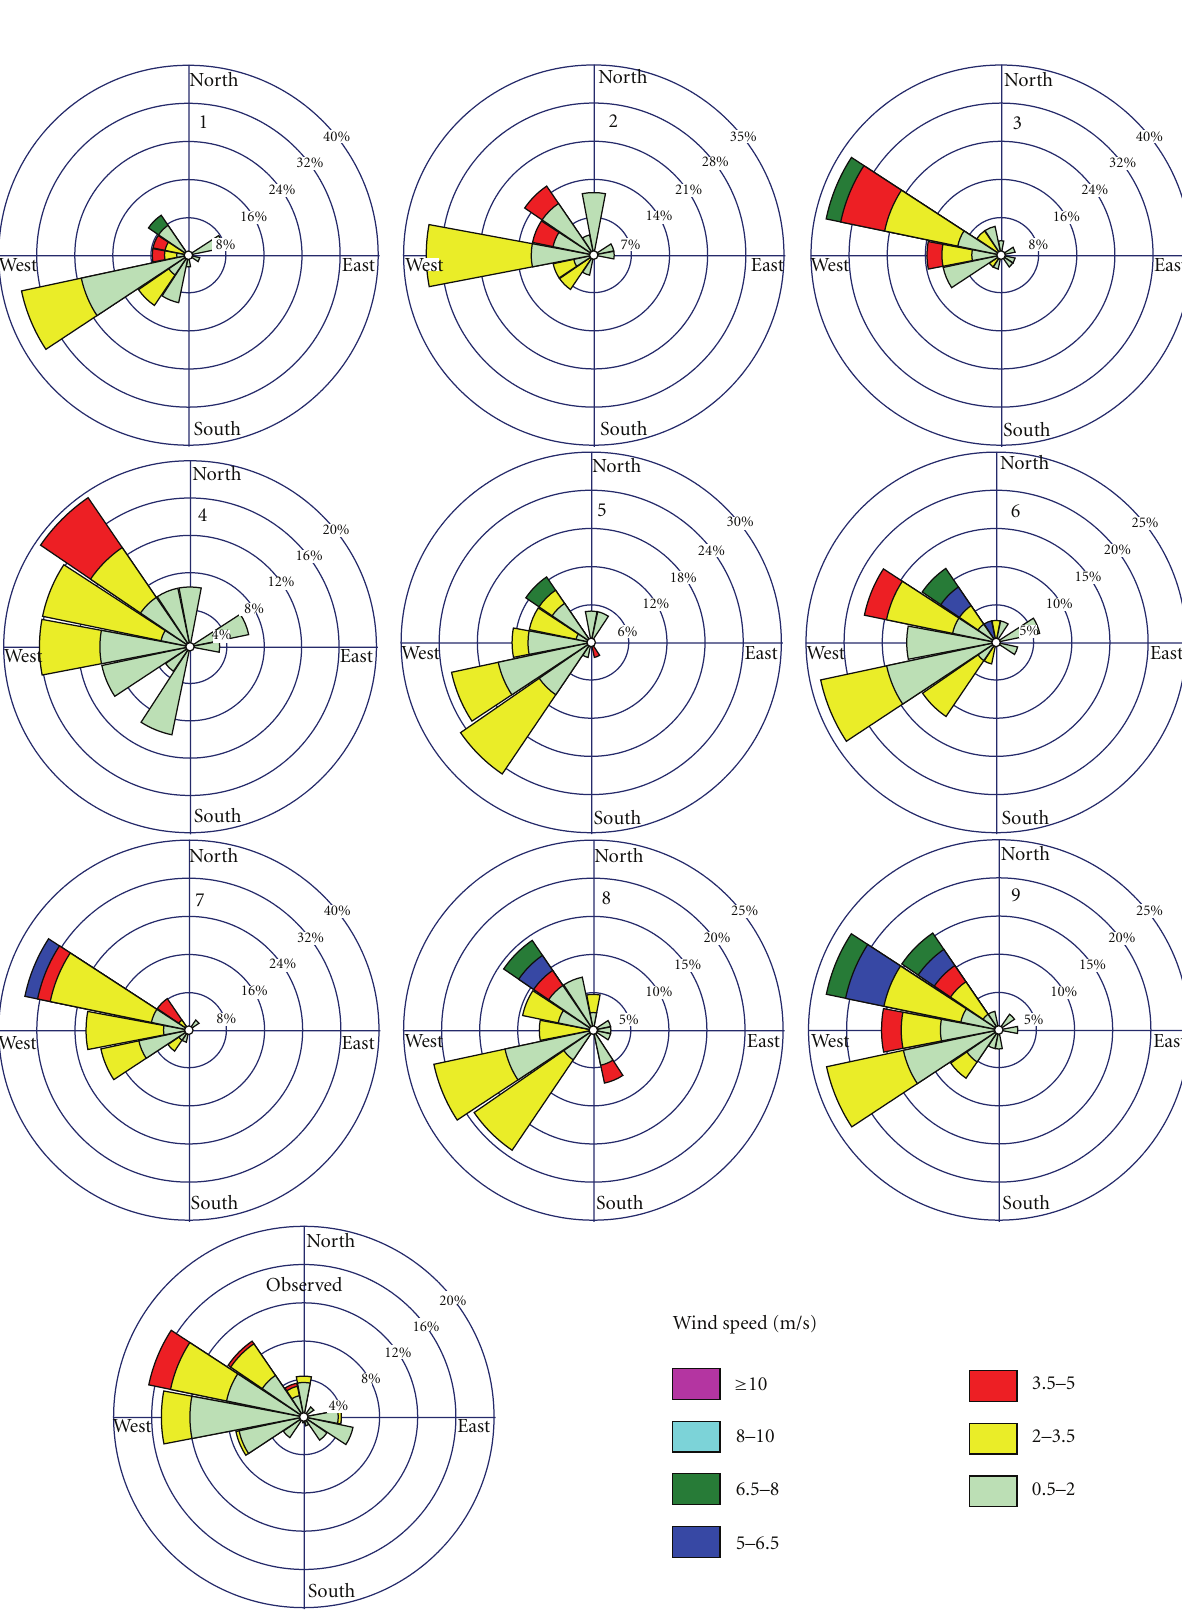
Figure 4: Wind roses for station 1 for winter